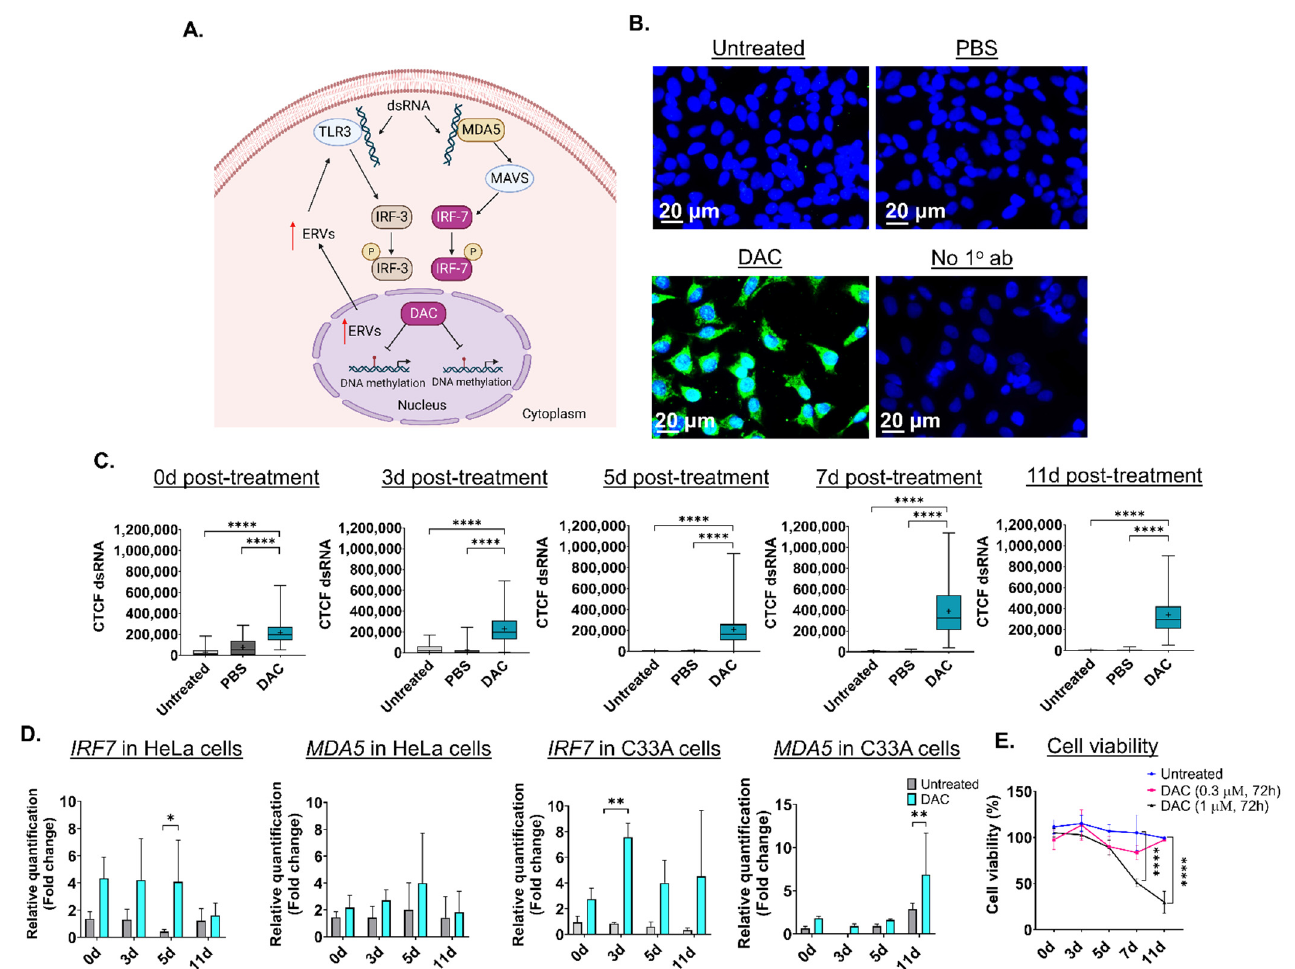
Figure 1. Low dose DAC treatment induces a viral mimicry response in HPV+ cells and HPV − cells in response to DAC treatment. ( A ) Illustration of the viral mimicry response induced by DAC treatment in cancer cells [20]. Figure created in BioRender [20,21,45]. ( B ) ICC/IF analysis of dsRNA in response to DAC (1 μΜ , 72 h) in HeLa cells at 11d post-treatment. Blue staining (DAPI) indicates the nucleus, and green fluorescence signal (AlexaFluor ® 488) indicates the staining for dsRNA. Untreated and PBS-treated cells were used as controls. Cells incubated without the primary antibody were used as the negative control. ( C ) Quantification of dsRNA levels in HeLa cells in response to DAC treatment at 0d, 3d, 5d, 7d and 11d was performed by measuring the corrected total cell fluorescence (CTCF) using ImageJ as follows: CTCF = Integrated density − (area of selected cell × mean fluorescence of background readings [20]. Data represent the median with range of CTCF value from 100 cells per treatment condition for each time point. The mean is also indicated by a cross (+). The experiment is a representative repeat of two independent experiments. Statistical analysis was performed using one-way ANOVA with Kruskal–Wallis test (**** p < 0.0001). ( D ) QPCR analysis of IRF7 and MDA5 gene expression levels in response to DAC treatment (0.3 μΜ , 72 h) at the indicated time points in HeLa cells and C33A cells. For all qPCR analysis, normalization to the mRNA levels of the housekeeping GAPDH was conducted. Relative quantification to the vehicle control (PBS-treatment) was performed. The fold change (2 −ΔΔ Ct ) was calculated and plotted showing the mean ± SD. The data presented are a representative repeat of two independent experiments. Statistical analysis was performed using two-way ANOVA with Tukey’s multiple comparisons test (* p < 0.05, ** p < 0.01). ( E ) Cell viability of HeLa cells in response to DAC treatment (1 μΜ , 0.3 μ M), for 72 h at 0d, 3d, 5d, 7d and 11d post-treatment using an MTT assay. The data are a representative repeat of three independent experiments. The data are plotted as the mean ± SD. Statistical analysis was conducted using two-way ANOVA with Tukey’s multiple comparisons test (**** p < 0.0001).